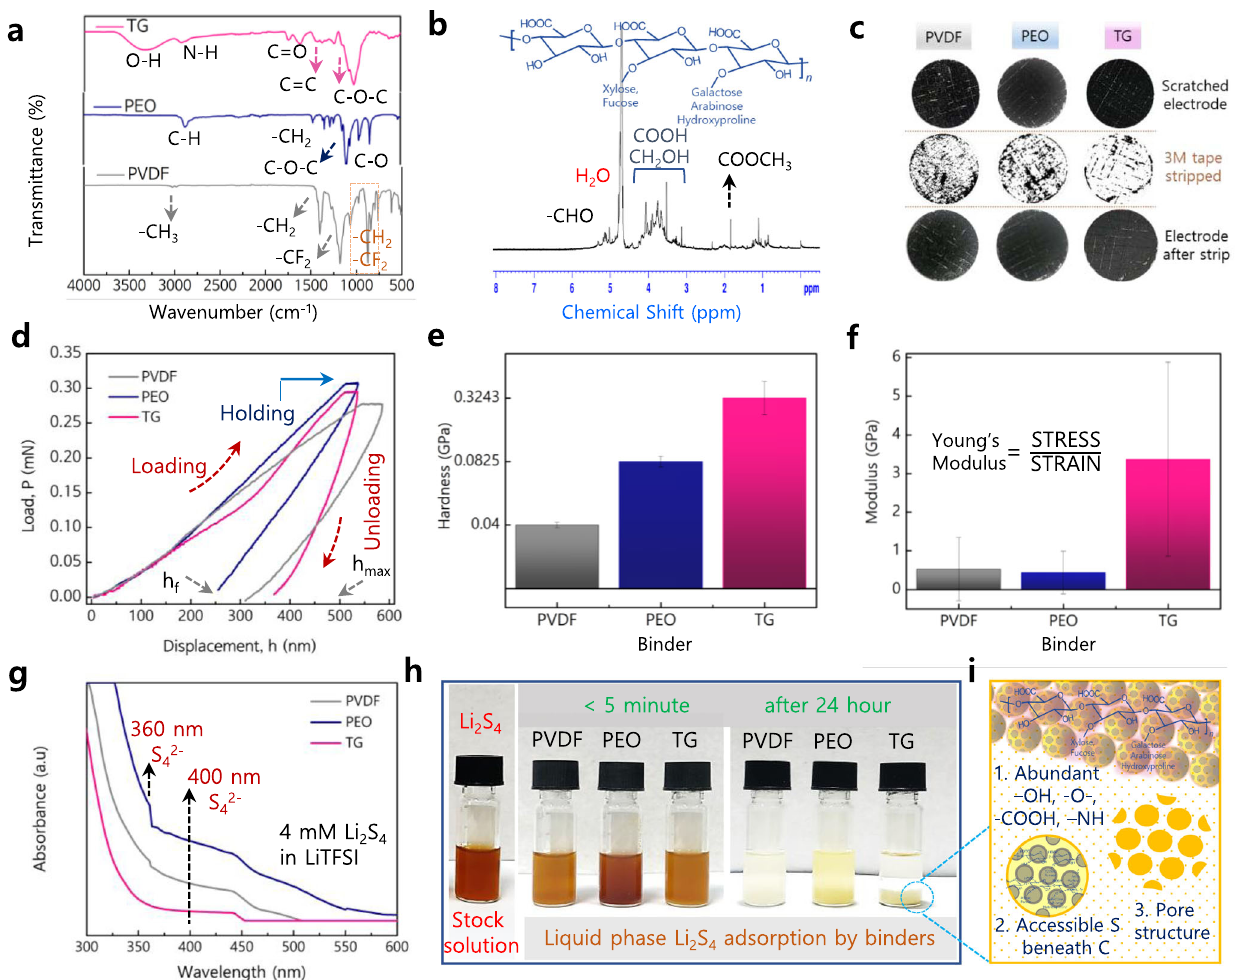
Fig. 6 Spectroscopic and mechanical studies for S/PVDF, S/PEO, and S/TG electrodes. a FT-IR spectra for various sulfur electrodes. b 1H NMR spectrum for pure TG. c Adhesion and peeling-off test. d Nanoindentation hardness test. e Hardness. f Elastic moduli. g Adsorption studies through UV- Visible. h Static adsorption of liquid phase polysul fi des by pristine PVDF, PEO, and TG binders. i Factors for high polysul fi de adsorption of TG